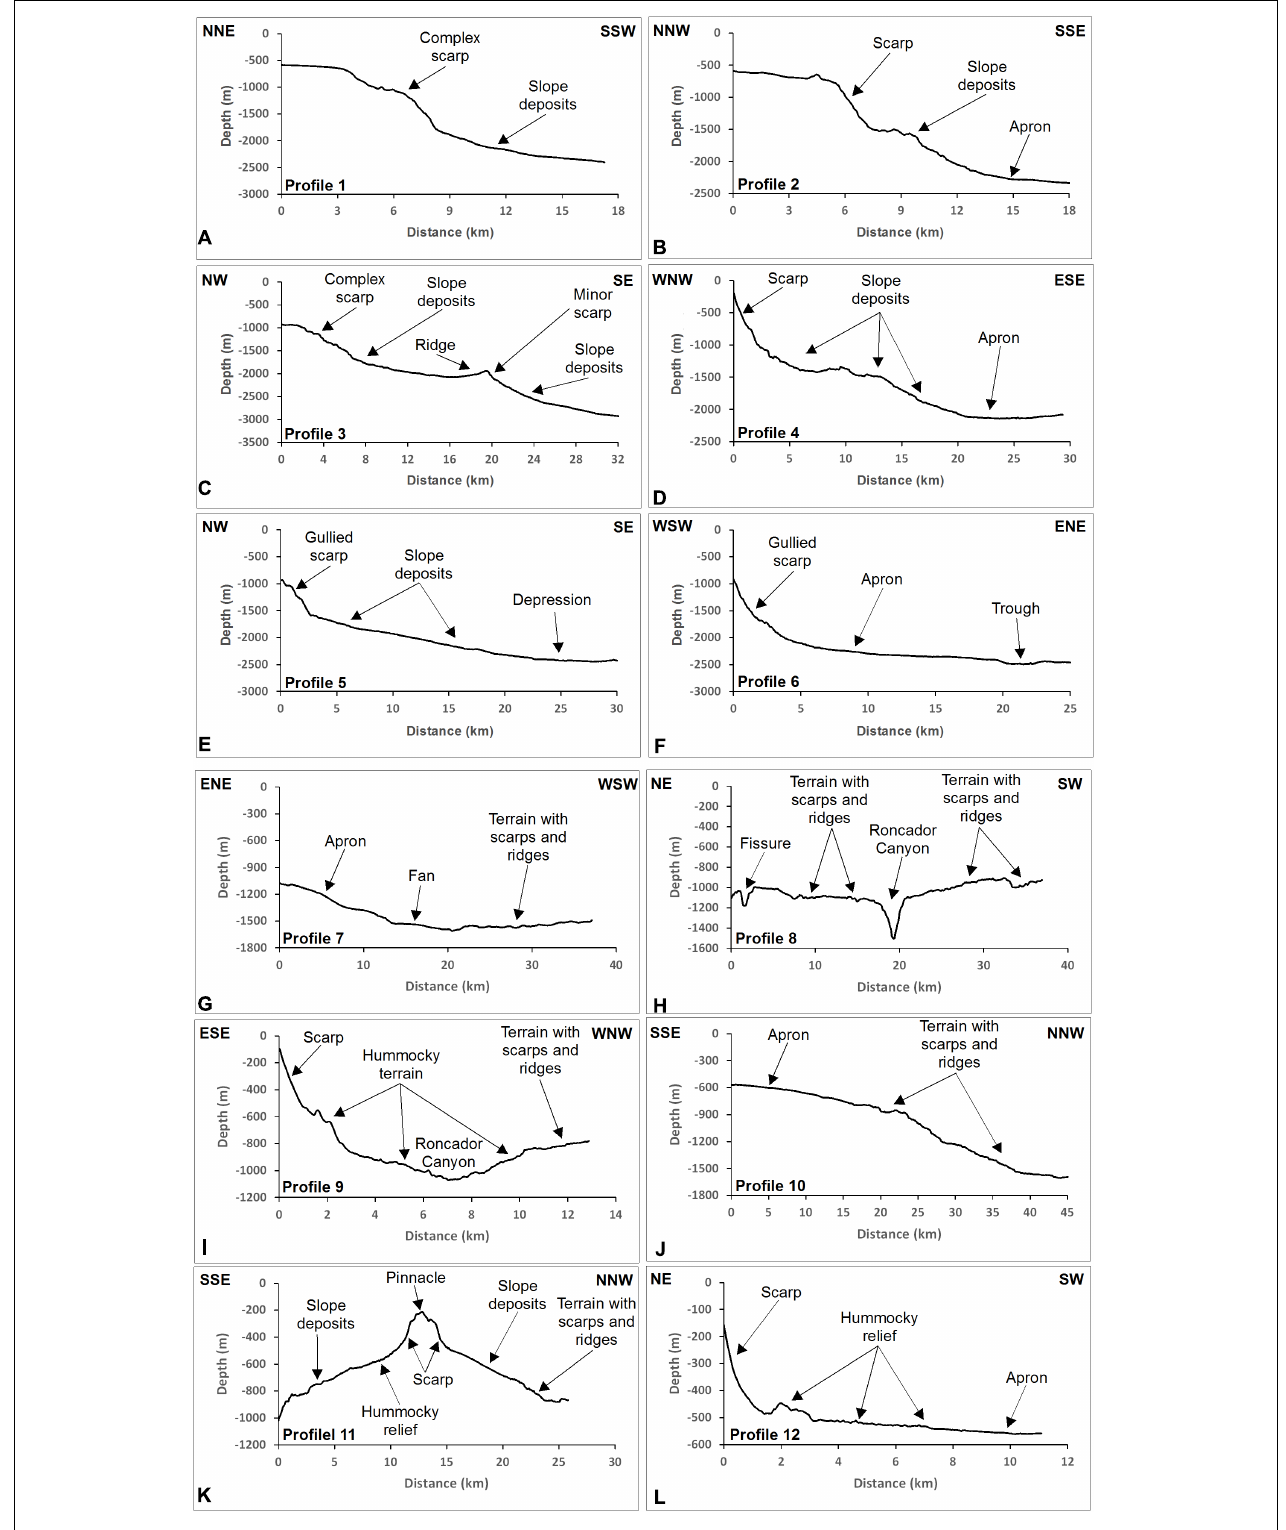
FIGURE 9 | Bathymetric profiles showing the main geomorphological features of Roncador Bank and adjacent areas. (A–C) Southern escarpment. (D–F) Eastern escarpment. (G–I) Northwestern sector. (J–L) Western sector. See Figure 2 for the profiles location.